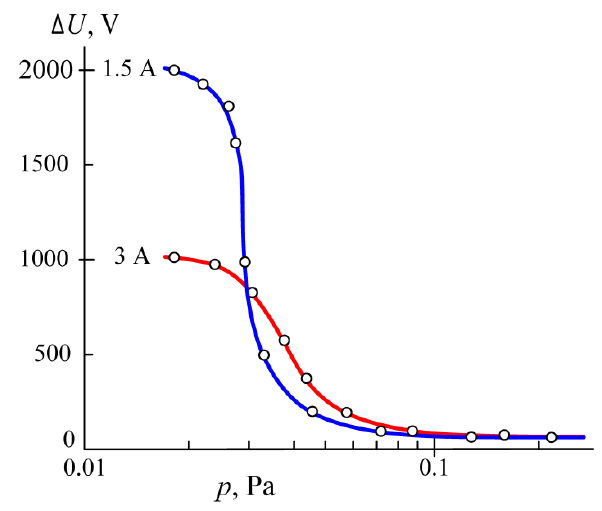
Figure 3. Dependences on the argon pressure p of the potential di ff erence ∆ U between the anode and the probe immersed in the plasma at the discharge currents I = 1.5 A and 3 A.